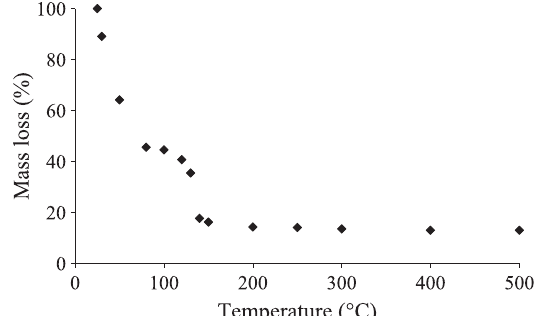
Fig. 3 Analyses of the